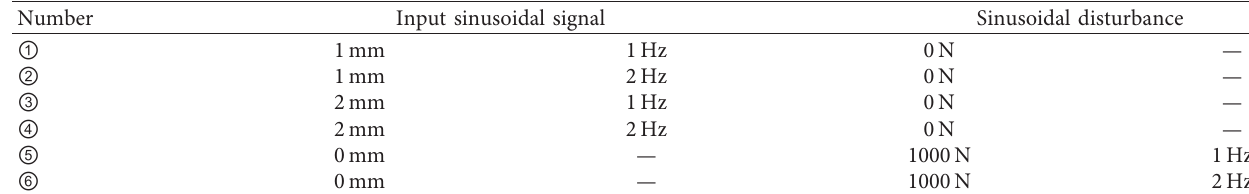
Table 4: Experimental plan of the HDU performance test platform.